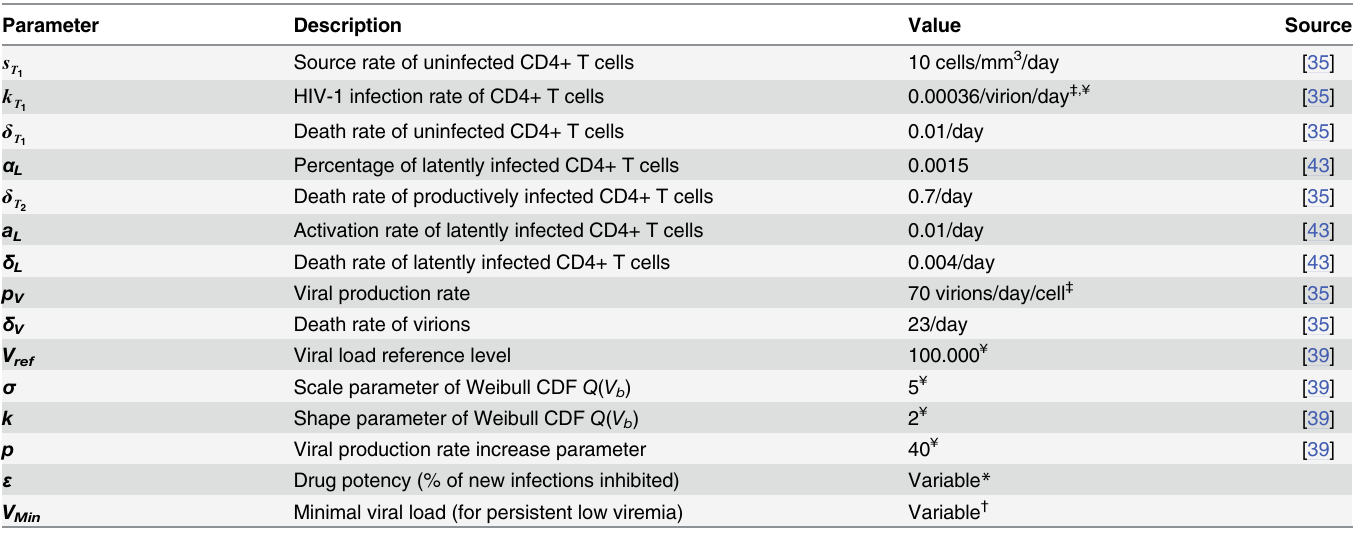
Table 3. Parameter values used in the basic HIV-D